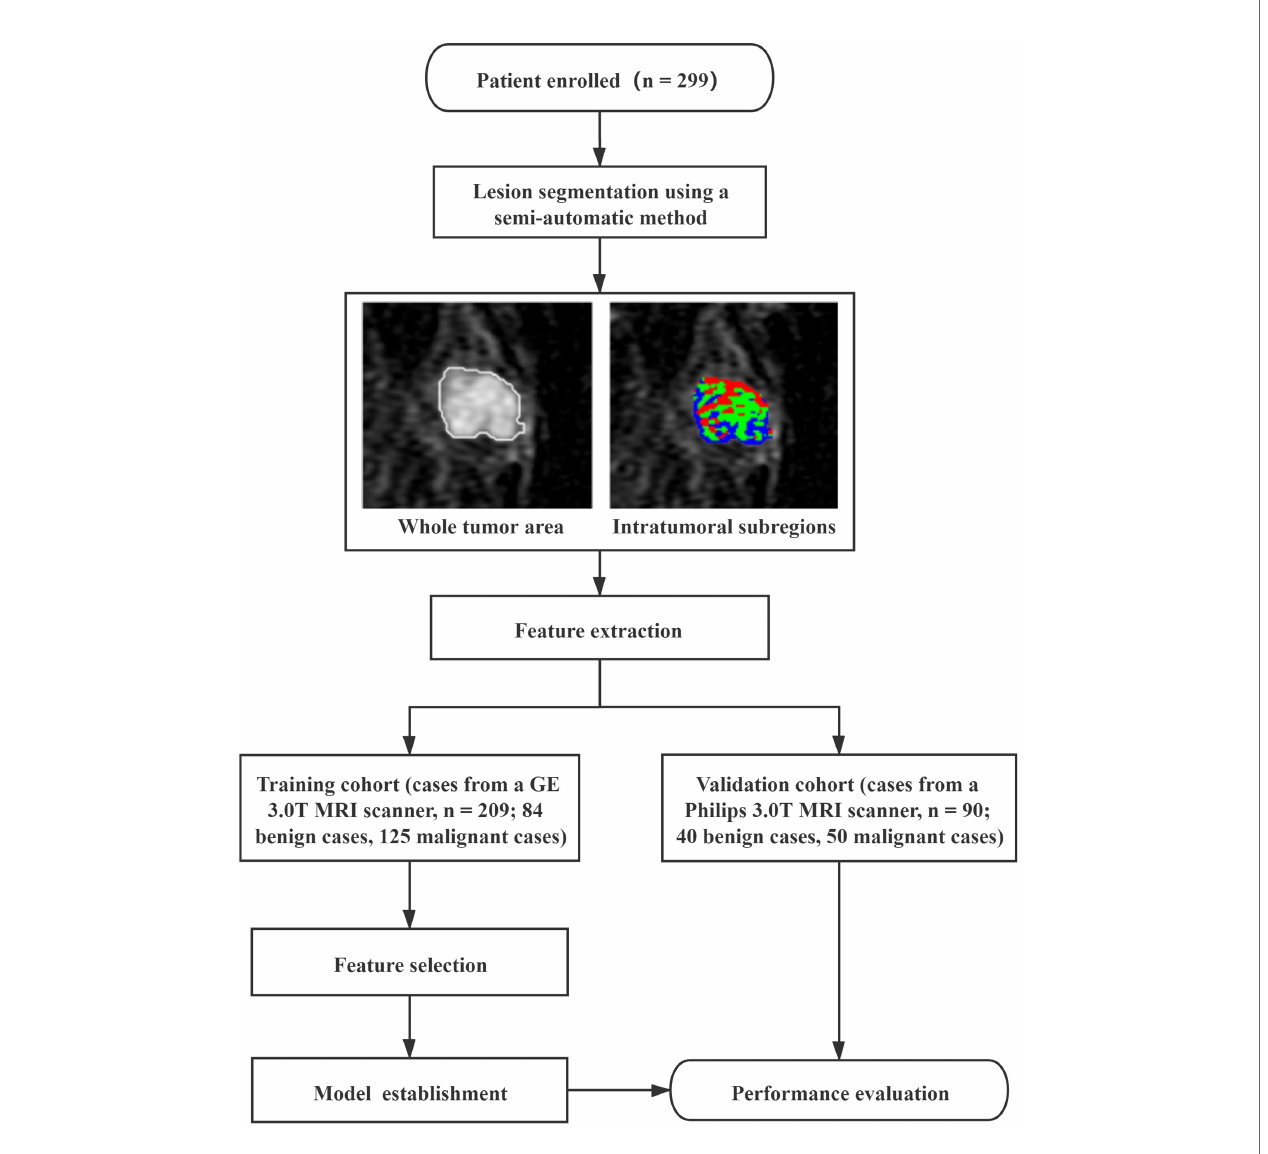
FIGURE 1 | The fl owchart adopted in this